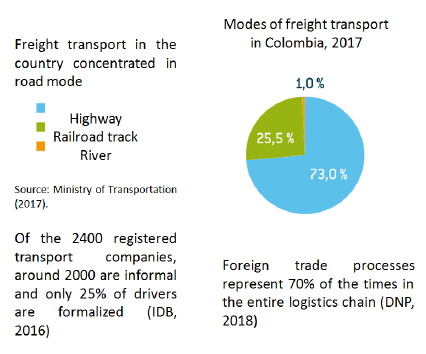
Fig. 3. Logistics Performance Index. Colombia and reference countries,